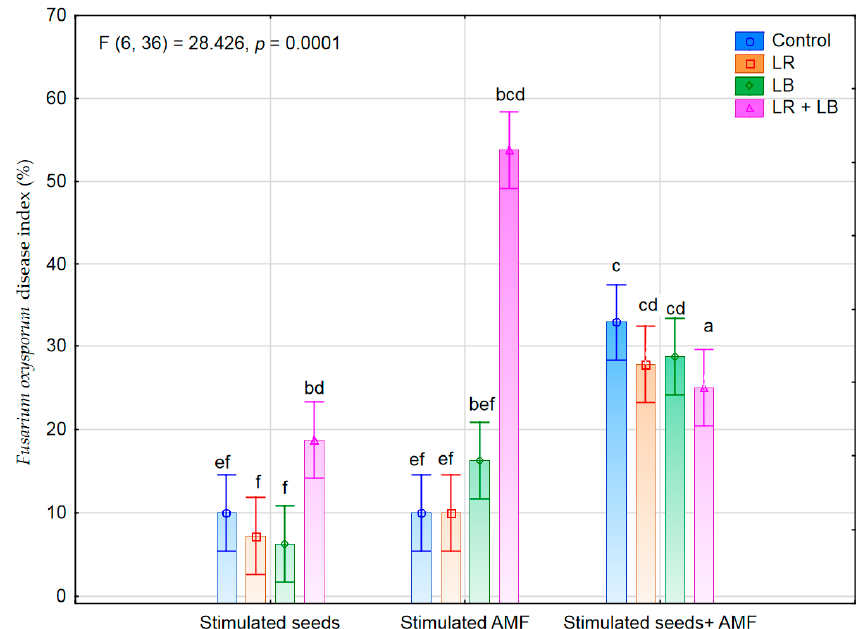
Figure 7. Fusarium oxysporum disease index (%) on the underground parts of soybean plants (roots) grown from seeds treated with arbuscular mycorrhizal fungi (AMF) and LR—helium-neon laser (red light), LB—argon laser (blue light), and LB + LR—Ar laser, followed by He-Ne laser. Different letters indicate the significant differences at p < 0.05.